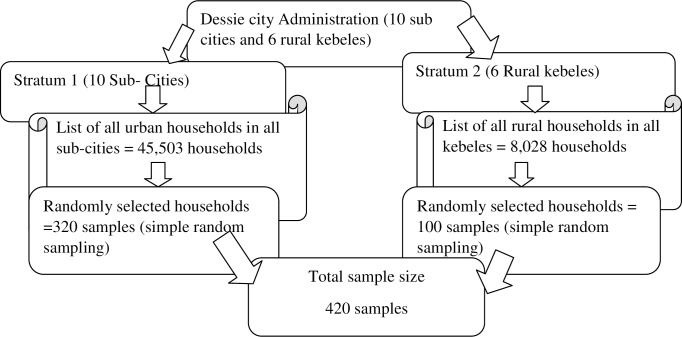
Sampling procedures.